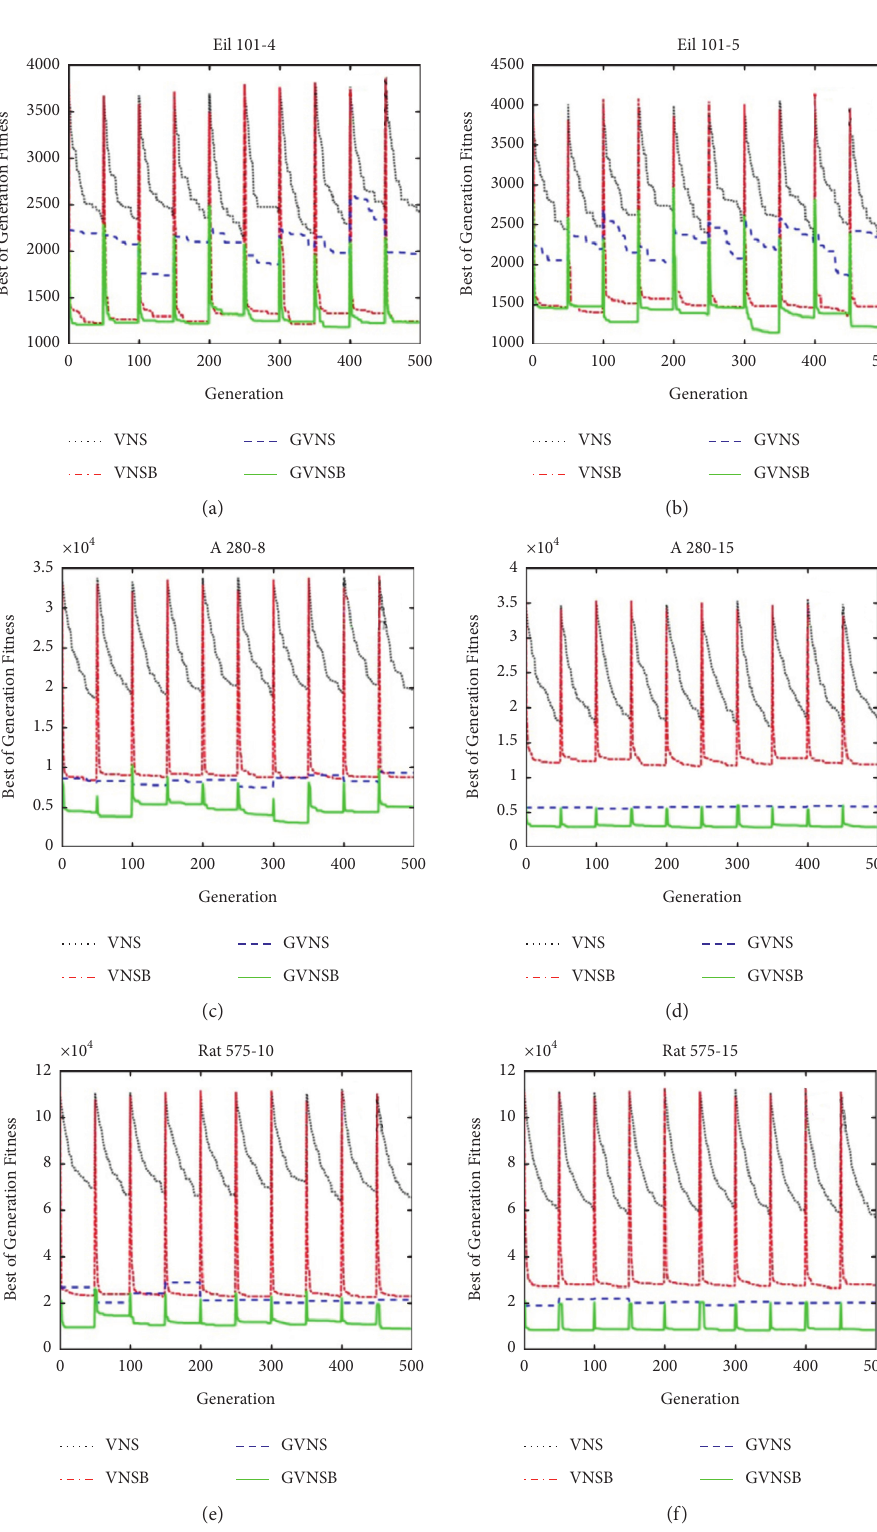
Figure 9: Dynamic performance of algorithms at different test cases in environment τ � 50. (a) Eil 101–4, ρ � 0 . 1. (b) Eil 101–5, ρ � 0 . 2. (c) A280-8, ρ � 0 . 2. (d) A280-15, ρ � 0 . 5. (e) Rat 575–10, ρ � 0 . 2. (f) Rat 575–15, ρ � 0 .